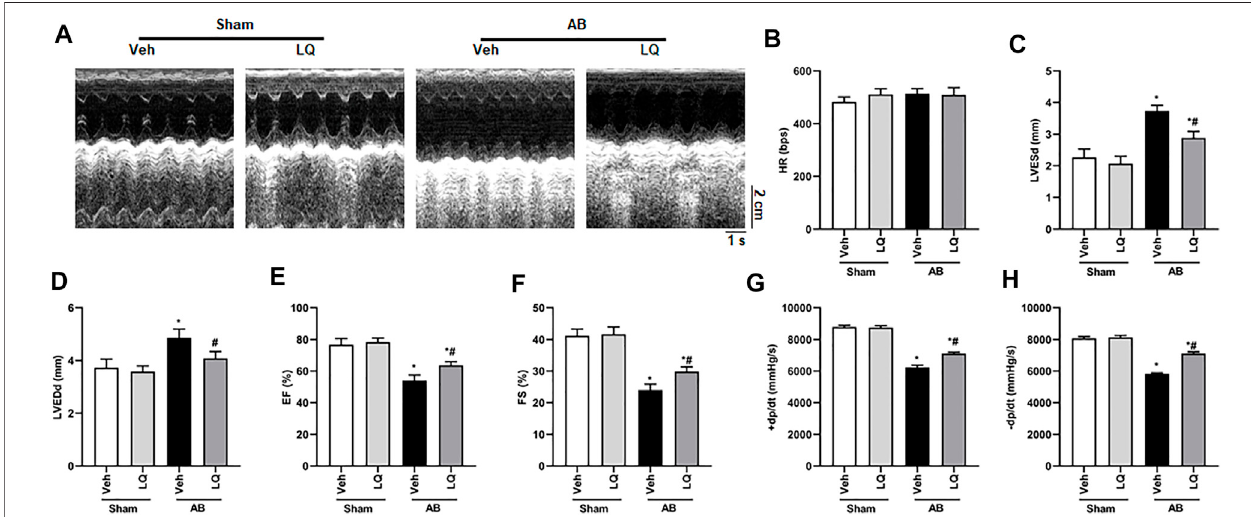
FIGURE 1 | Liquiritin attenuates hypertrophy-related cardiac dysfunction. Echocardiography and PV loop analyses were performed 4 weeks after AB ( n = 10) or sham ( n = 6) surgery. (A) Representative echocardiographic images. (B) Heart rate (HR). (C) Left-ventricular end-systolic diameter (LVESd). (D) Left-ventricular end- diastolic diameter (LVEDd). (E) Ejection fraction (EF). (F) Fractional shortening (FS). (G) Left ventricular maximum rate of pressure rise (dP/dt max). (H) Left ventricular maximumrateofLVpressuredecay(dP/dtmin).Dataarepresentedasthemean±SEM.One-wayANOVAwasperformedtoexaminestatisticaldifferencesamong different groups. * p < 0.05 vs. Sham + Veh; # p < 0.05 vs. AB +